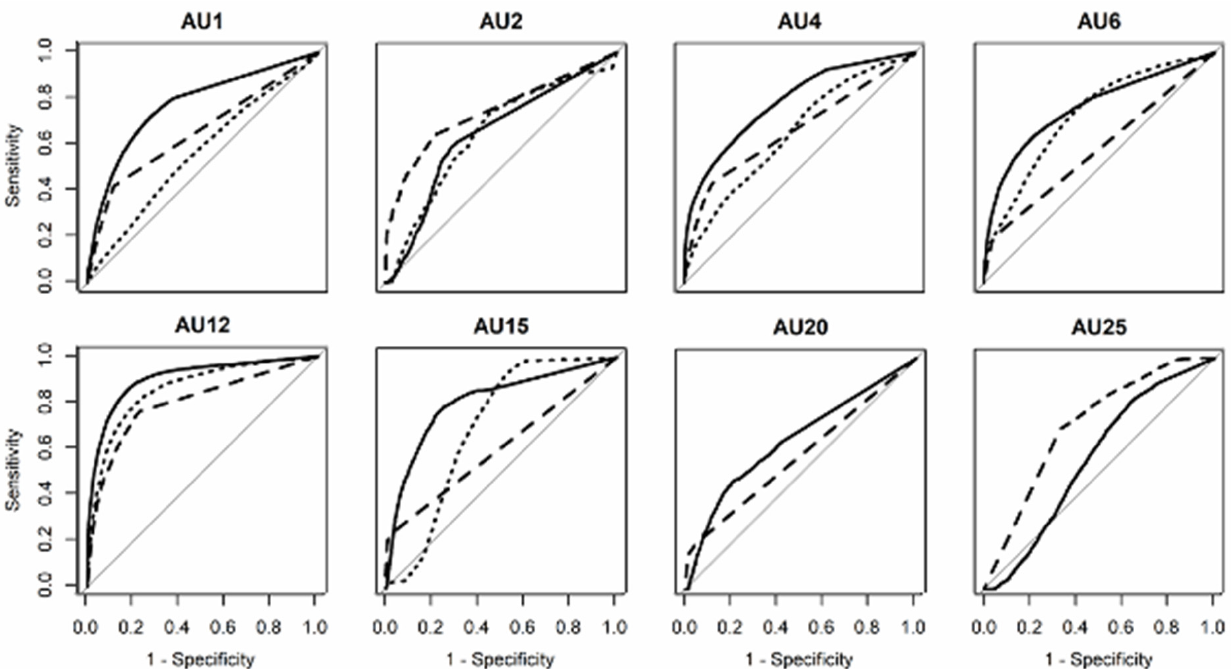
Figure 3. Receiver operating characteristic curves for each action unit in the Aff-wild2 (in-the-wild) database obtained by the three machines. Solid line represents OpenFace, dashed line represents FaceReader, and dotted line represents AFAR. The diagonal line indicates random performance).